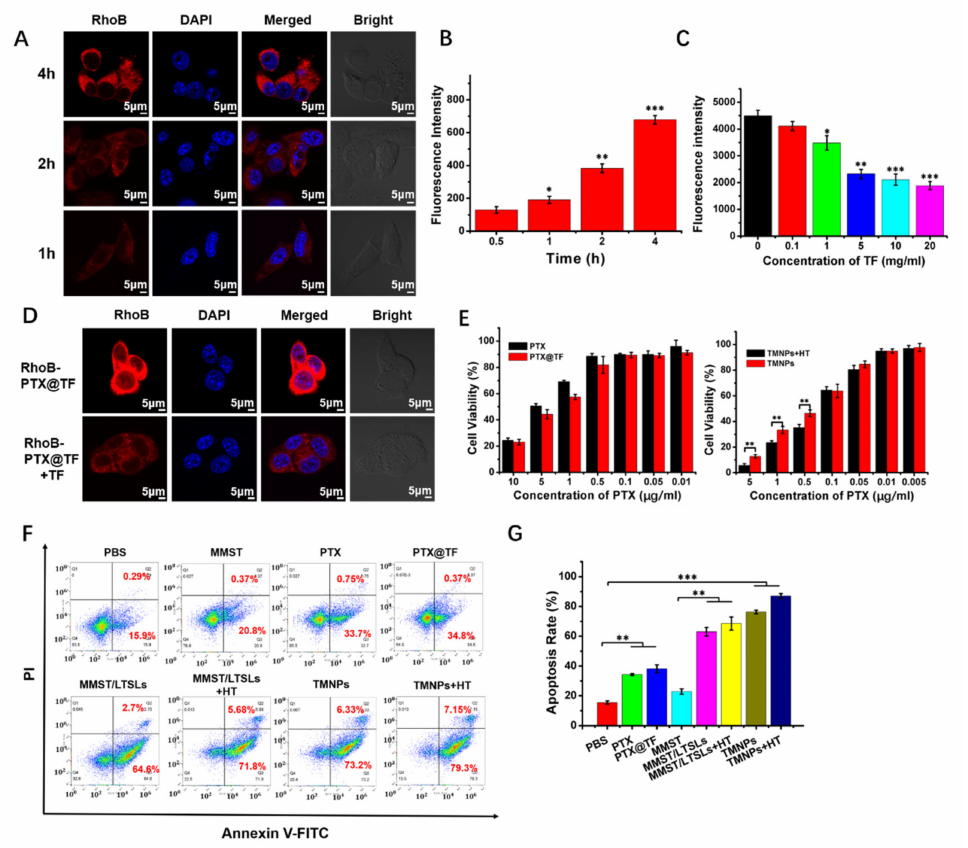
Figure 3. TFR-mediated endocytosis and in vitro cytotoxicity. ( A ) CLSM images and ( B ) fluorescence intensity of RhoB- PTX@TF in 4T1 cells after incubation for 0.5 h, 1 h, 2 h and 4 h at 37 ◦ C. ( C ) Cellular uptake of RhoB-PTX@TF (red) with preincubation by different TF concentrations in 4T1 cells after 4 h incubations at 37 ◦ C. The fluorescence intensity was measured by flow cytometry. ( D ) CLSM observation of cellular uptake. RhoB-PTX@TF (red) were treated with 4T1 cells with or without preincubation with 10 mg/mL TF for 4 h at 37 ◦ C. The scale bar is 5 µ m. ( E ) Cell viability after treatment with PTX, PTX@TF and TMNPs, and TMNPs by at 37 ◦ C. PTX had an equal concentration to MMST in TMNPs. ( F ) Flow cytometry analysis and ( G ) quantitative analysis of apoptosis induced by PBS, PTX, MMST, PTX@TF, MMST/LTSLs, MMST/LTSLs with HT (MMST/LTSLs + HT), TMNPs, and TMNPs with HT (TMNPs+HT) for 48 h at 37 ◦ C. All the formulations were prepared at a PTX and/or a MMST concentration of 5 µ g/mL. Cells were stained with FITC-Annexin V and PI (mean ± SEM, n = 3, * p < 0.05, ** p < 0.01, *** p <